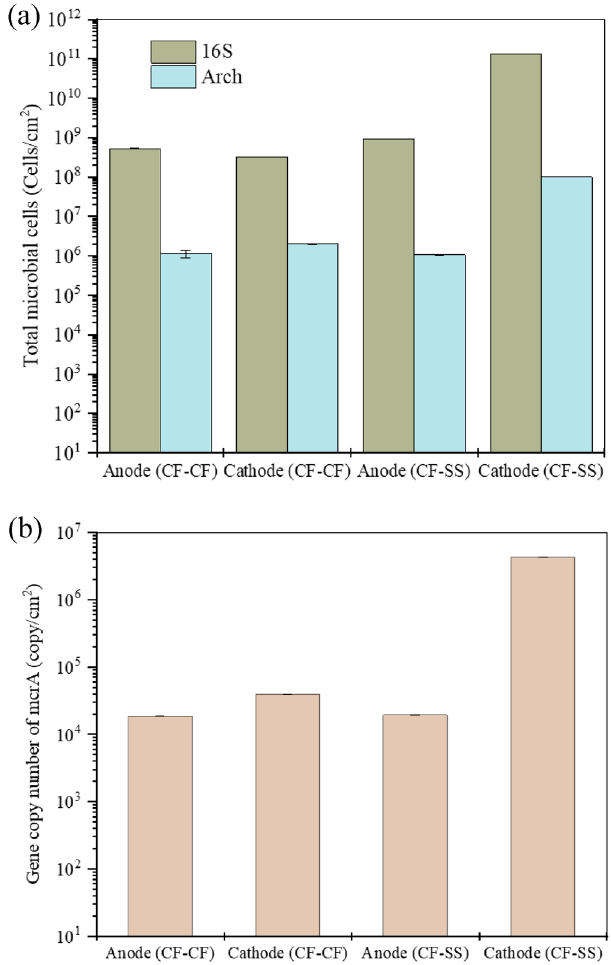
Figure 4. Total cell number using 16 s and archaeal primers ( a ), and mcr A gene copies ( b ). The error bars indicate the standard deviation of three replicates (n =